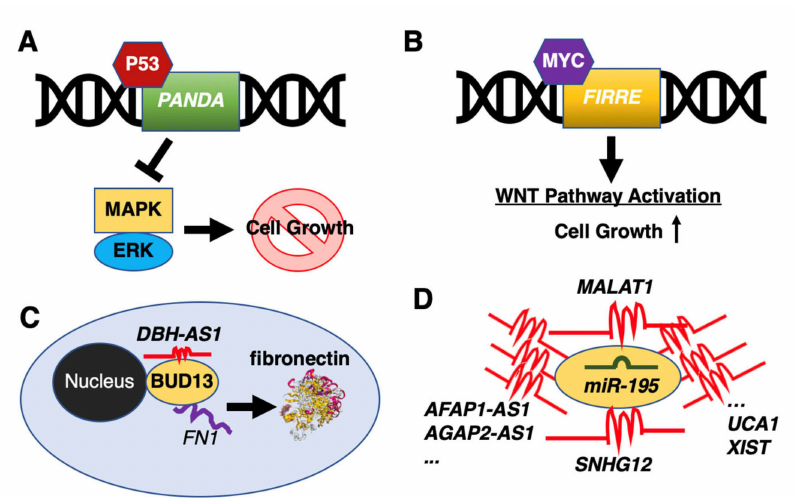
Figure 1. Representative long non-coding RNAs (lncRNAs) in diffuse large B-cell lymphoma (DL- BCL). ( A ) The p53-activated PANDA inhibits cell growth through inactivation of the MAPK/ERK pathway. ( B ) The MYC-activated FIRRE activates the Wnt/ β -catenin signaling pathway to facilitate DLBCL cell growth. ( C ) The lncRNA DBH-AS1 controls the translation of fibronectin 1 (FN1) through binding to the RNA-binding protein, BUD13. ( D ) Many lncRNAs have been suggested to function as miRNA sponges to sequester miR-195